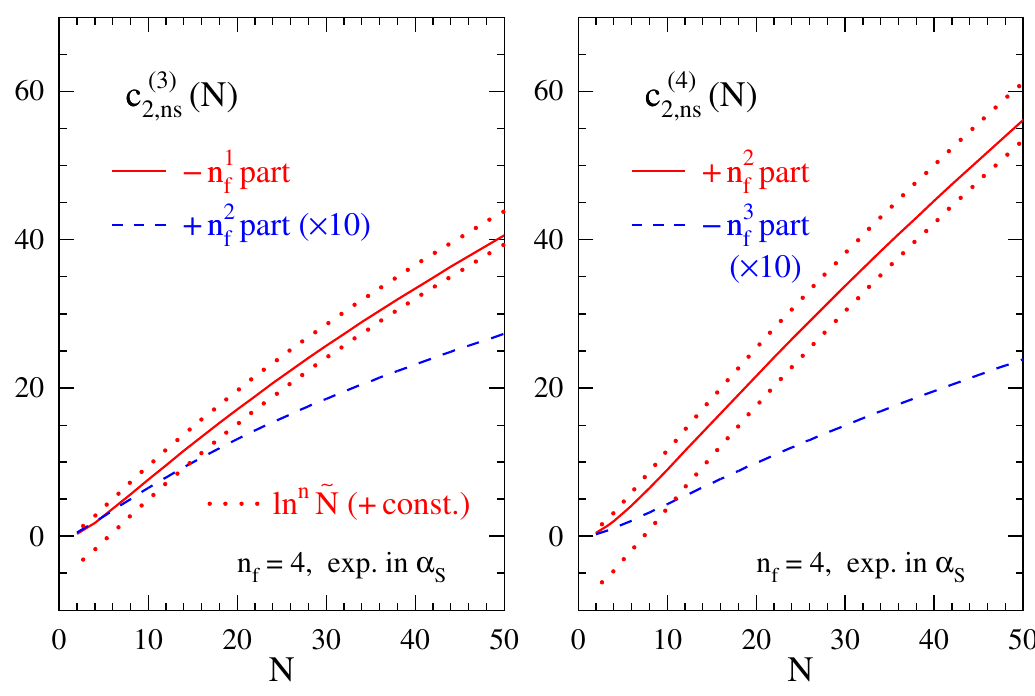
Figure 4 . As figure 3, but for the structure function F 2 , ns . In addition the ln ‘ e N and ln ‘ e N + const. threshold contributions are shown here, respectively, by the upper and lower dotted